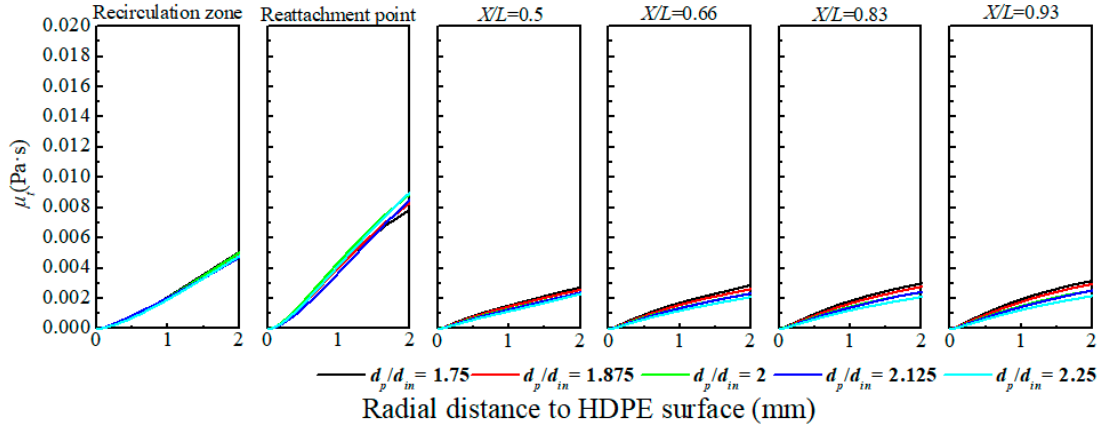
Figure 31. Radial profiles of the turbulent viscosity ( μ t ) at different axial positions in , solid fuel ramjet (SFRJ) combustor of different cases.